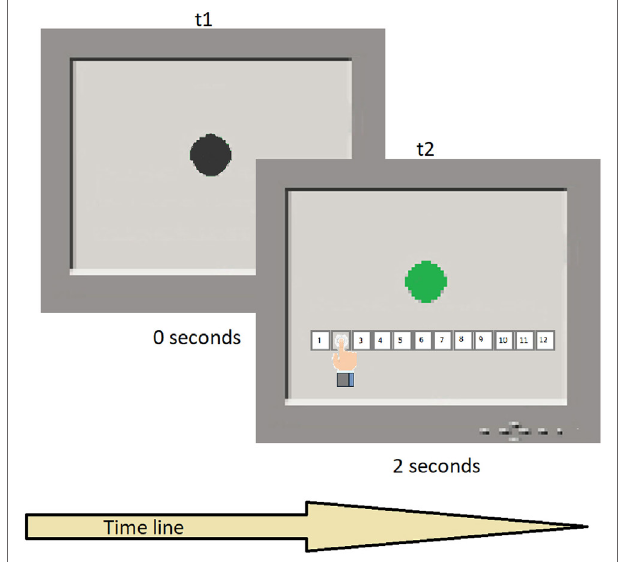
FigUre 1 | Typical trial sequence. t1 shows the black circle presentation in the screen; t2 shows the color switch after a temporal interval and the participant’s